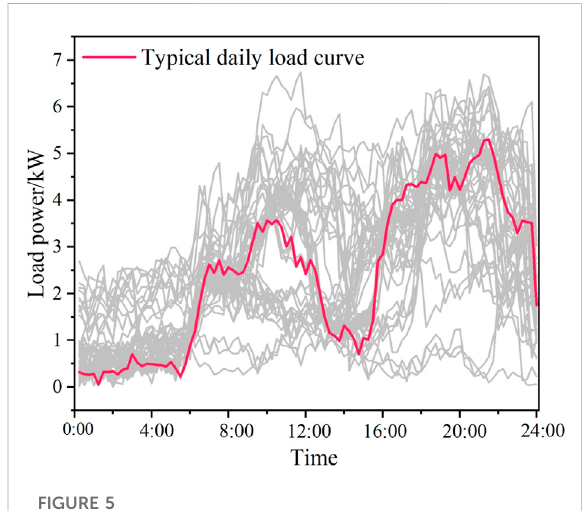
FIGURE 5 The typical daily load curve for a user in the load dataset.